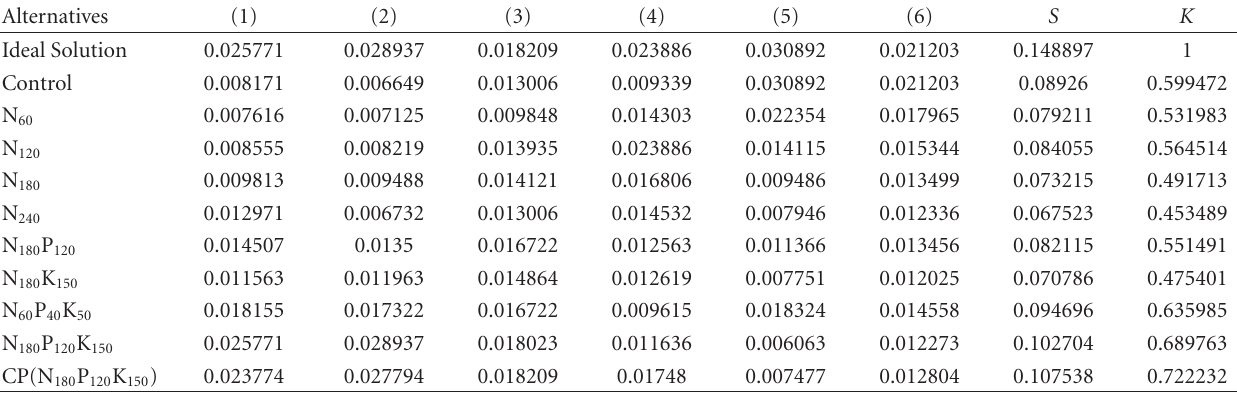
Table 5: Normalized values ( (cid:9) x ij ) of decision-making matrix according to ARAS method.